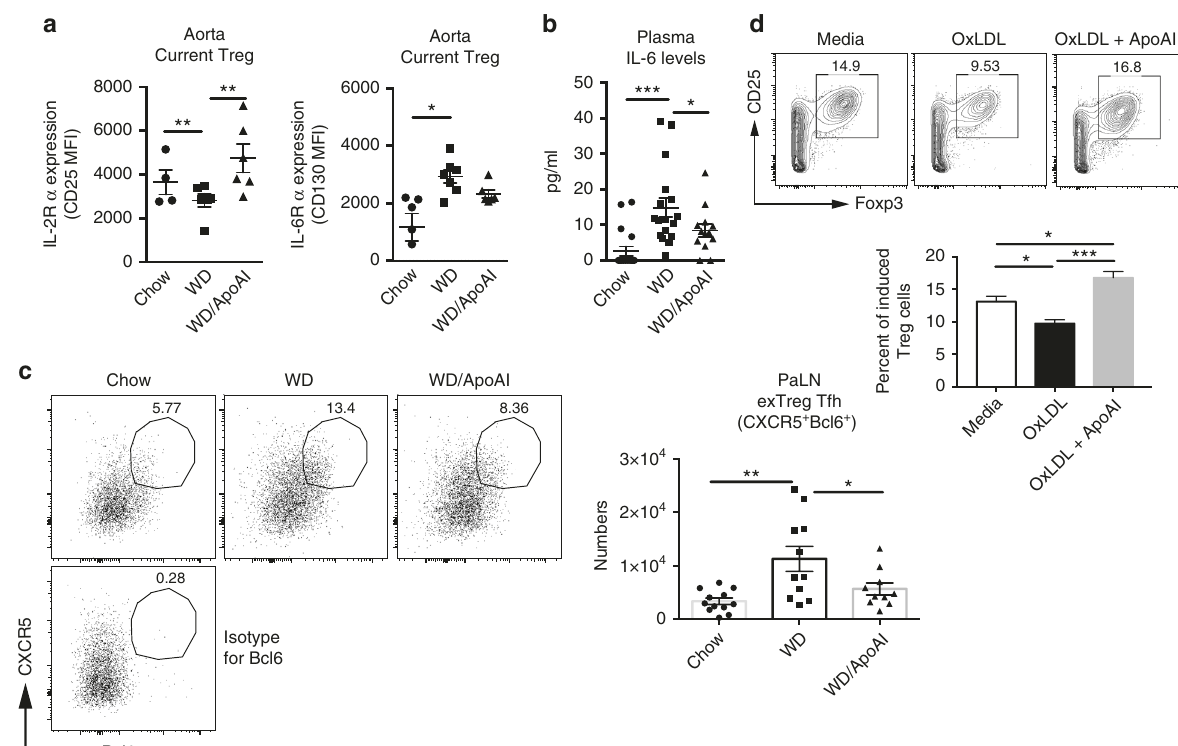
Fig. 8 ApoAI administration increases IL-2R α expression and reduces IL-6 production and Bcl6 expression during atherogenesis. a Expression of IL-2R α (CD25) and IL-6R α (CD130) on current Treg in the aorta of LT-ApoE − / − western diet-fed mice with and without ApoAI treatment or chow controls. b Plasma levels of IL-6 in the mice described above. c Flow cytometry plots and graphs showing the percentages and numbers of CXCR5 + Bcl6 + Tfh in exTreg cells of above mice. Plots are gated on CD44 + RFP + YFP − CD4 T cells. d Naive CD4 T cells from ApoE − / − mice were isolated and stimulated with α CD3/CD28 and TGF β to induce Treg in vitro with or without the addition of oxLDL or ApoAI. Flow cytometry plots and graphs showing the percentages of induced Treg following 4 days in culture. Results are expressed as the mean ± s.e.m. from one of two independent experiments ( n = 6 (Chow and WD/ ApoAI), n = 7 (WD)) ( a ), mean ± s.e.m. from 3 different experiments ( n = 18 (Chow), n = 17 (WD) and n = 13 (WD/ApoAI)) ( b ), the mean ± s.e.m. from two independent experiments ( n = 11 (Chow and WD) and n = 10 (WD/ApoAI) ( c ), and the mean ± s.e.m. from one of two experiments ( n = 4) ( d ). Statistical signi fi cant differences were at * P < 0.05, ** P < 0.01 and *** P < 0.001 (one-way